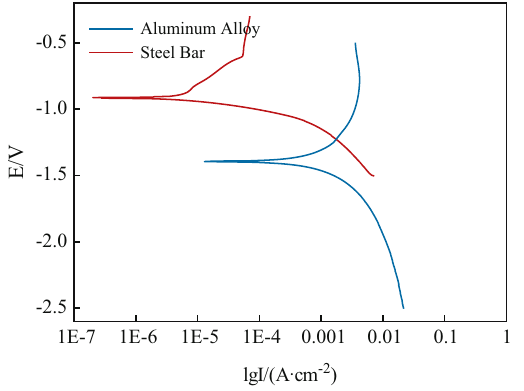
Figure 12: Polarization curves of the steel bar and aluminium alloy in the saturated Ca ( OH ) 2 solution.